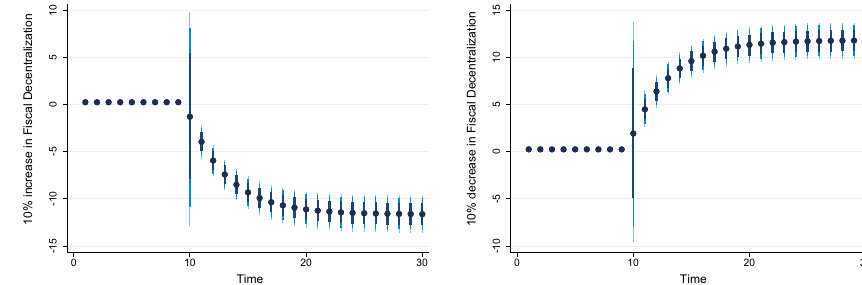
Fig. 3 The Impulse Response Plot for Fiscal Decentralization and CO 2 Emissions. Figure 3 presents an increase and a decrease by 10% in fiscal decentralization and its effect on CO 2 emissions where dots denote average prediction value. The dark blue to light blue line shows 75, 90, and 95% confidence interval,